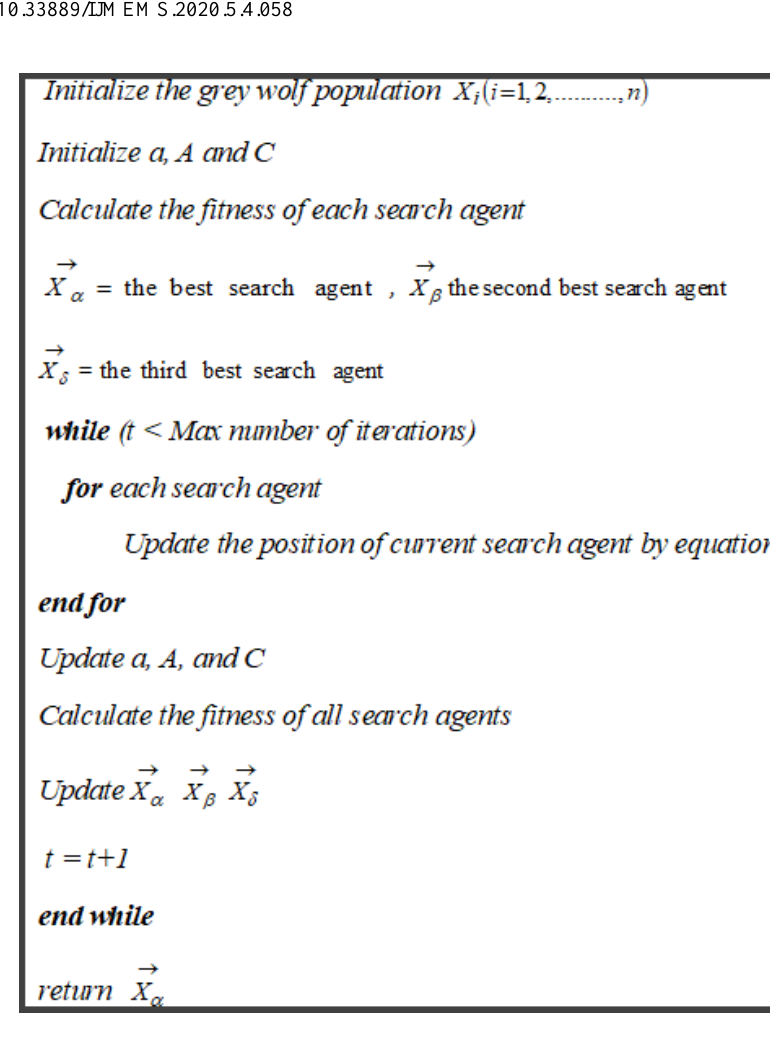
Figure 4. GWO algorithm pseudo